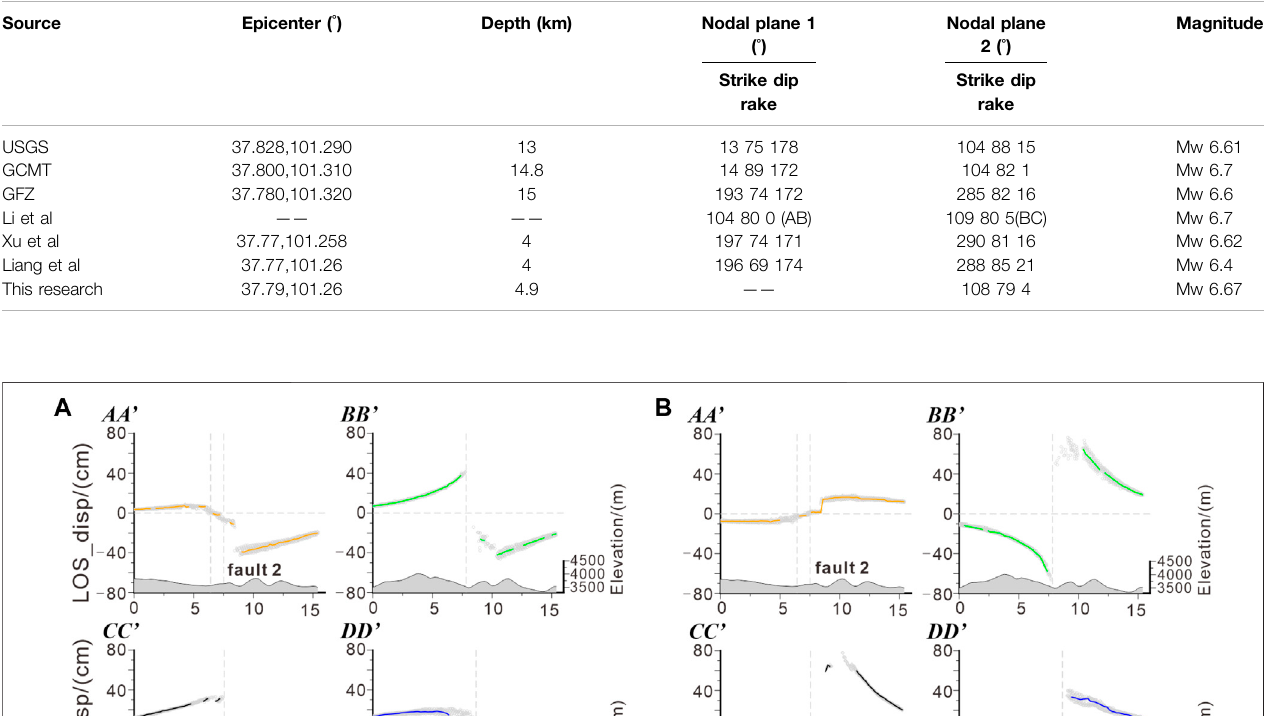
TABLE 2 | Focal mechanism solutions of the Menyuan Ms 6.9 earthquake.